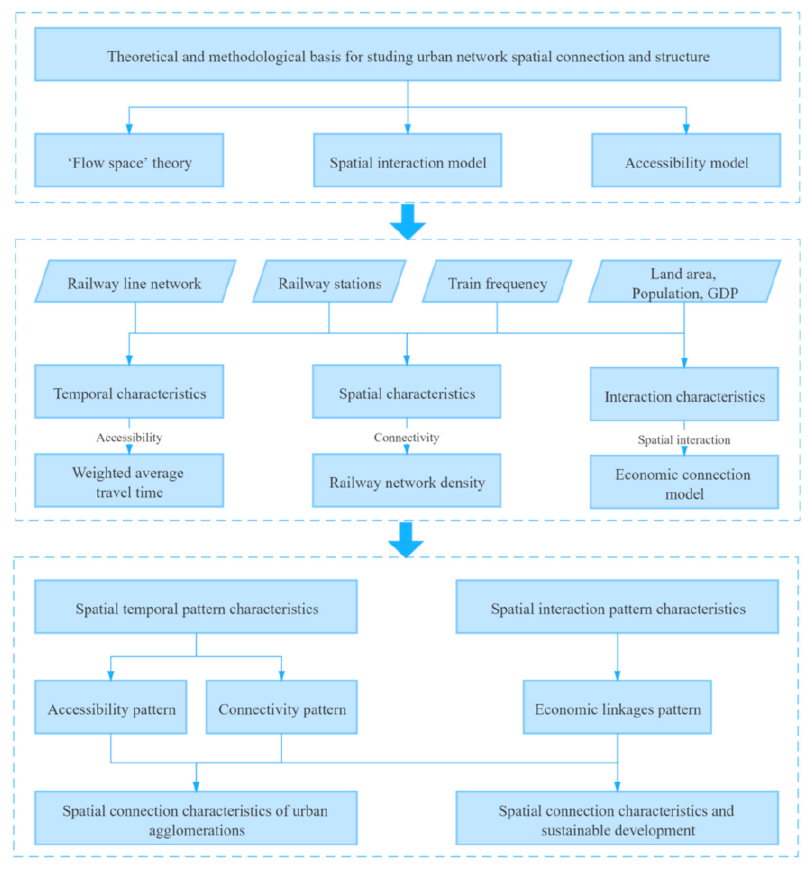
Figure 2. Technical framework for this